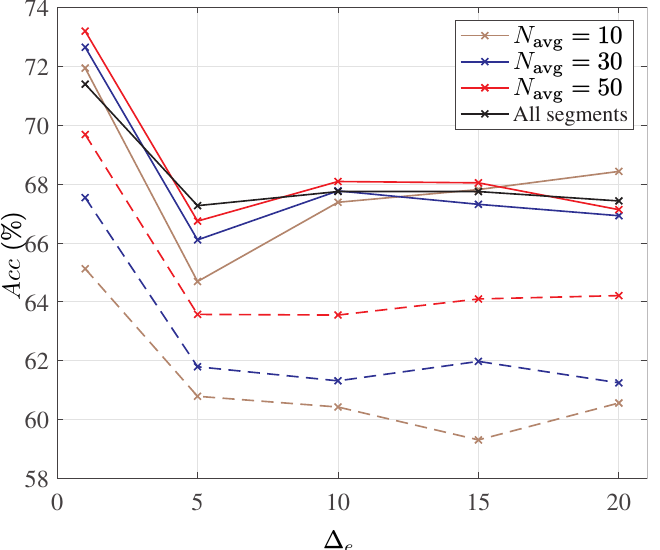
Figure 8. The accuracy of the random forest classifier vs. the maximum misalignment ∆ s for a different number of the averaged fragments N avg . Solid line: consecutive segment selection; dashed- line: random segment